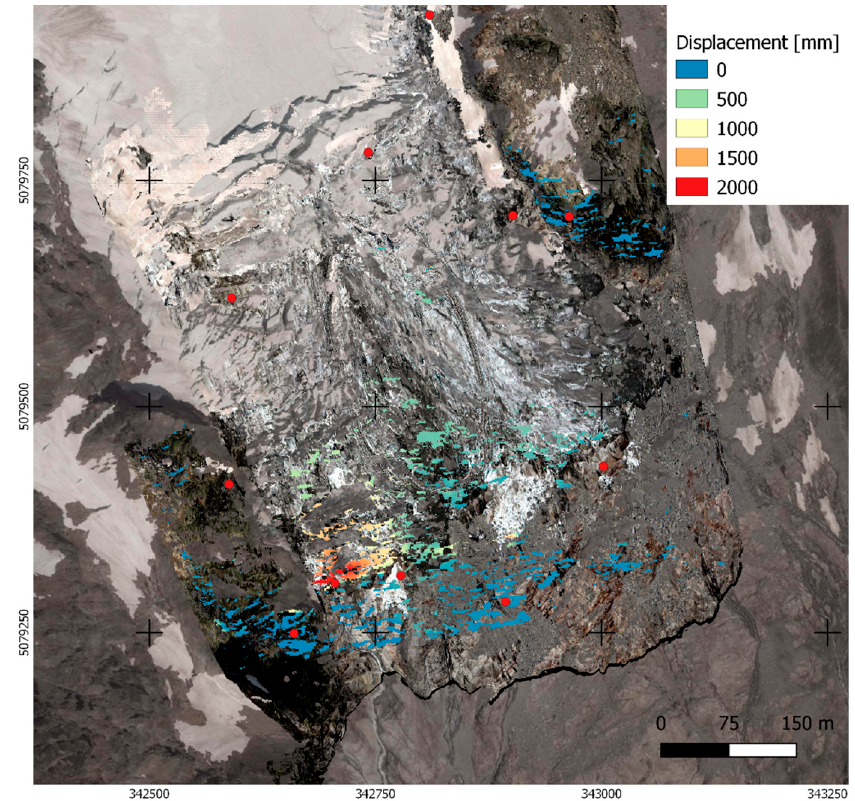
Figure 8. Three ‐ dimensional daily displacement of the Planpincieux glacier between 31 July and 1 August 2020 obtained from the fusion of DIC and TRI results. The orthorectified oblique photographs is overlain on a Google Earth image. The red dots indicate the ground control points adopted to orthorectify the oblique picture.